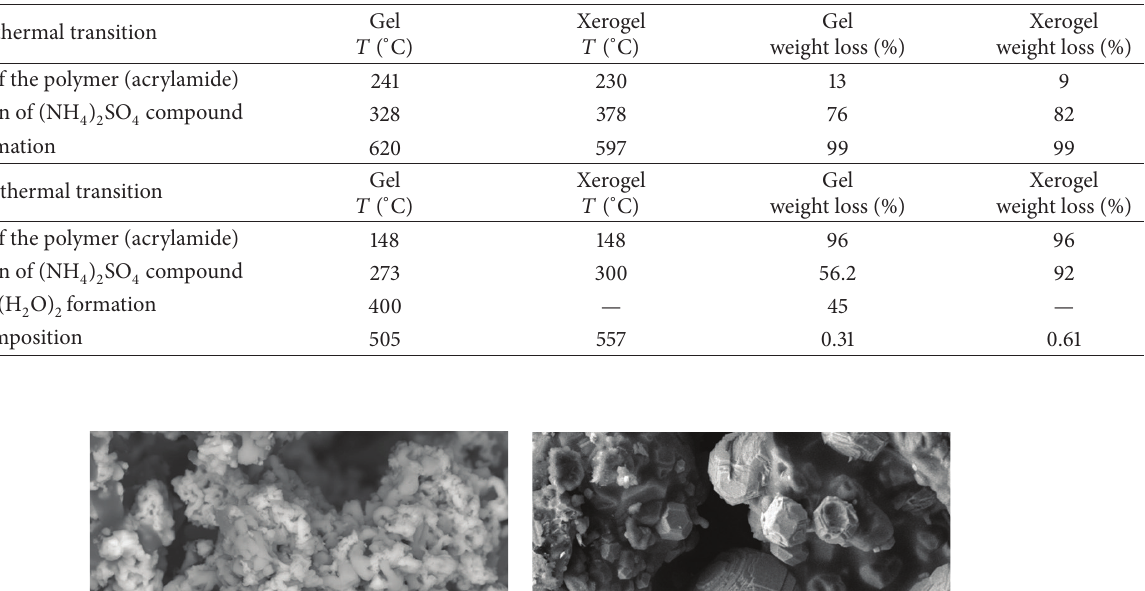
Table 1: Study of thermal transitions for the Rh and Pd gel and xerogel, respectively.